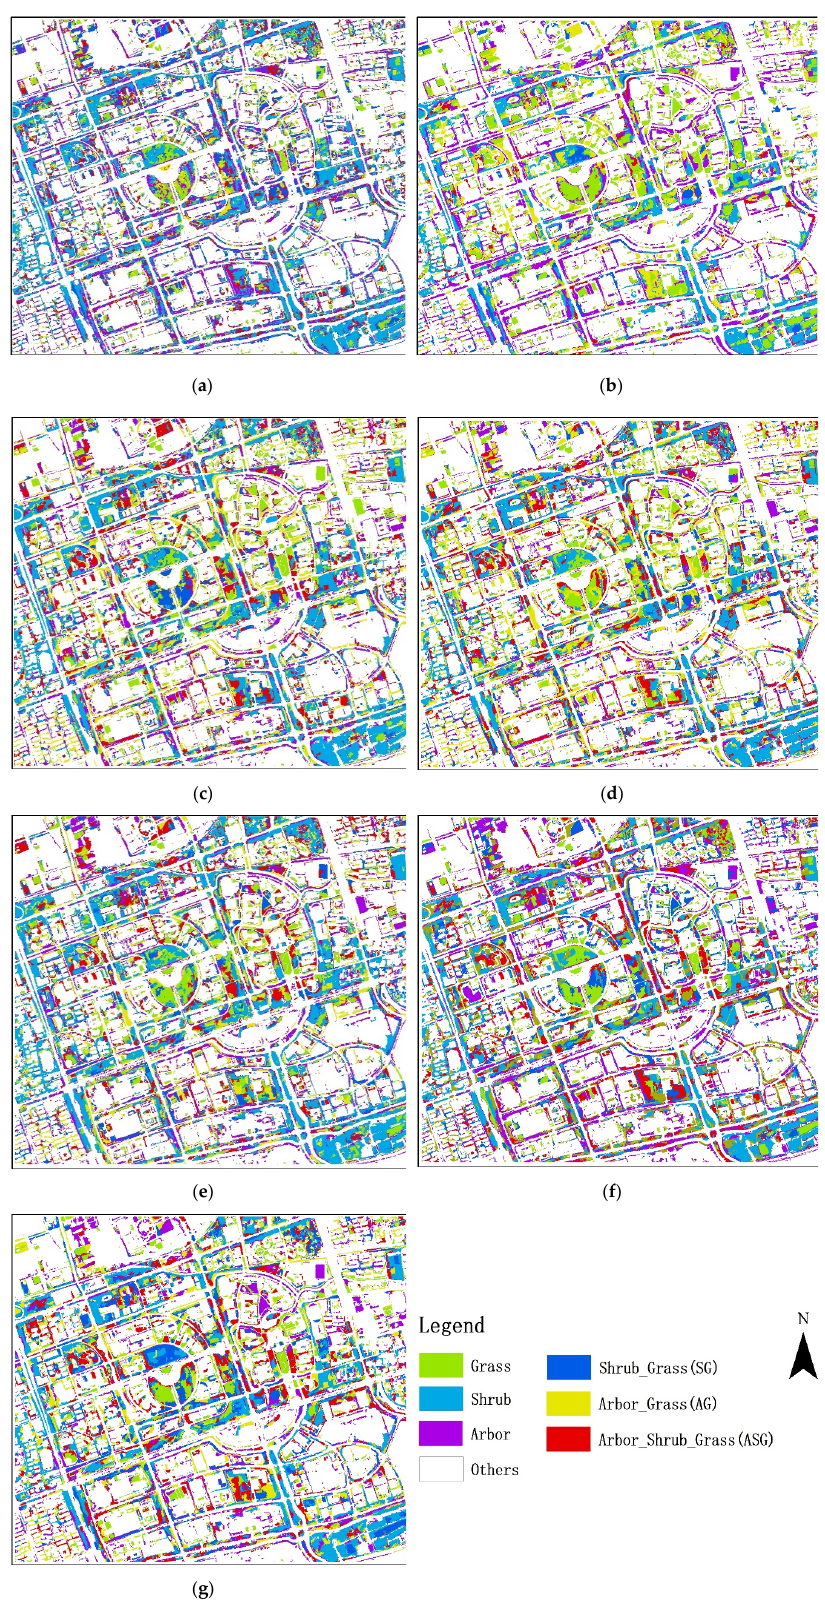
Figure 4. Classification map of urban vegetation types in Shanghai based on di ff erent CLBP window textures, using only spectral information ( a ) and combining spectral information with CLBP window texture in Shanghai at 3 × 3 ( b ), 5 × 5 ( c ), 7 × 7 ( d ), 9 × 9 ( e ), 11 × 11 ( f ), and 13 × 13 ( g ).